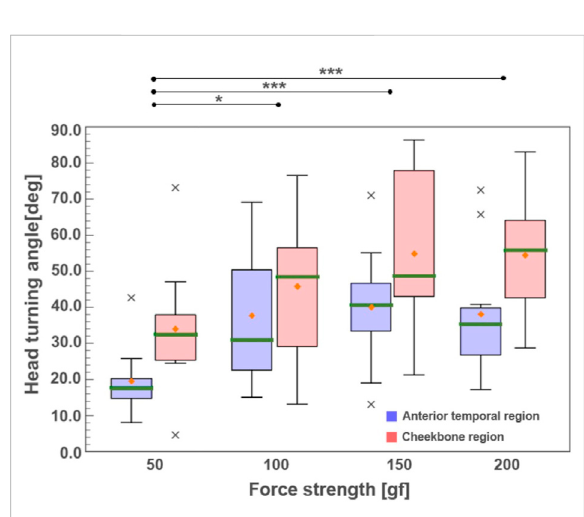
Head rotation angle during the anterior part of the temporal head stimulation (***: p < 0.001, *: p <